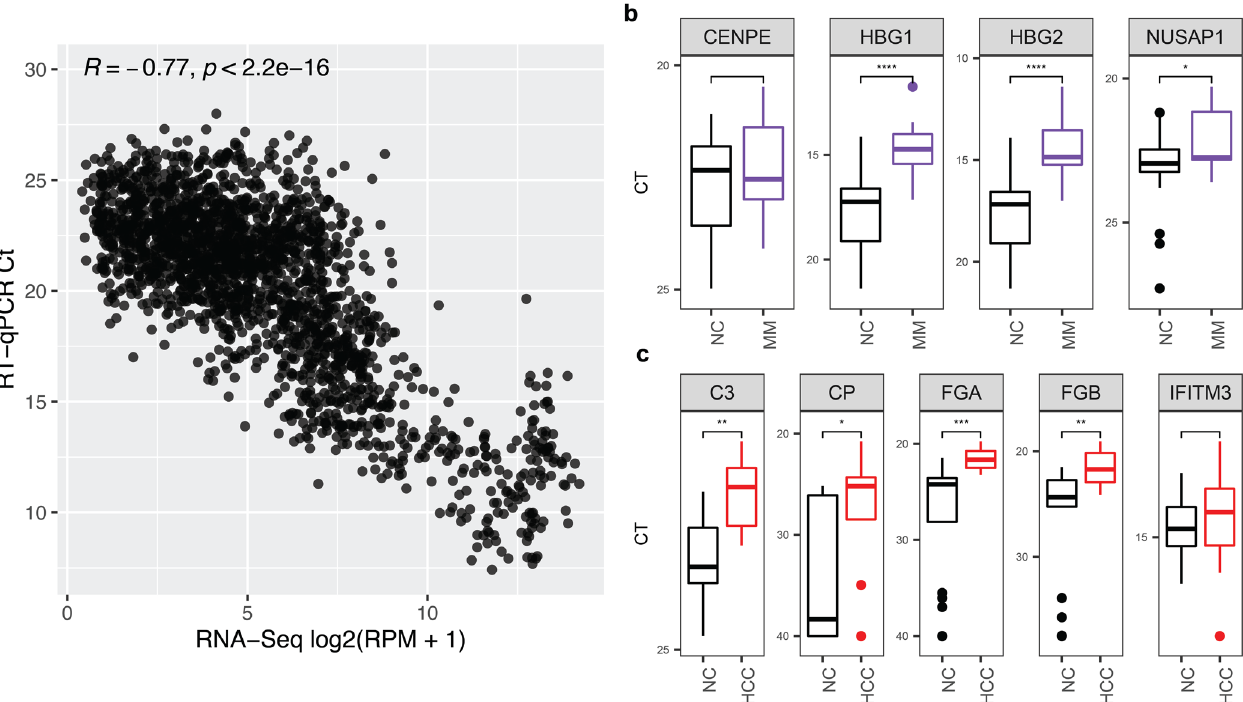
Fig. 4 qRT-PCR of cfRNA biomarkers is concordant with RNA-sequencing data. a Correlation plot of qRT-PCR data compared to RNA- sequencing data. P value was calculated by t-test. b , c qRT-PCR Ct values of top four LVQ genes identi fi ed from MM versus NC ( b ) and top 5 LVQ genes identi fi ed from HCC versus NC ( c ). Center-line for boxplots in both b and c indicates the median value across all patients in that group, and the hinges represent the lower (Q1) and upper (Q3) quartile, with whiskers extending to the minimum and maximum of the resulting